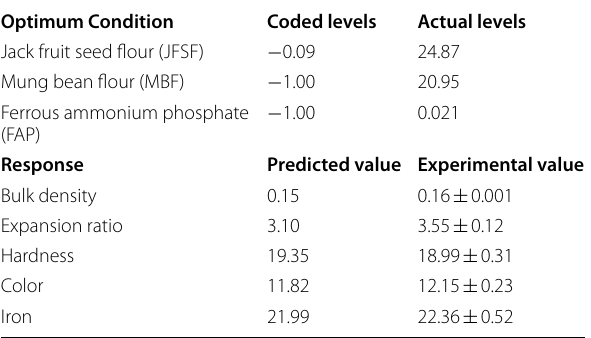
Table 4 Optimum conditions, experimental and predicted